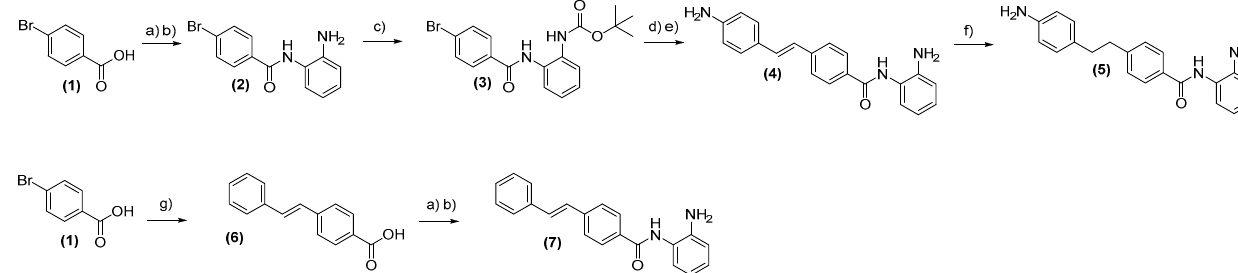
Figure 8. Synthesis of compounds ( 4 ), ( 5 ), and ( 7 ).